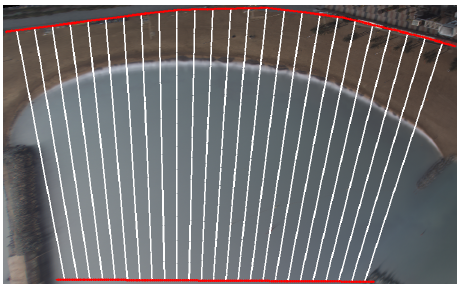
Figure 2. Somorrostro beach in Barcelona (beach BCN3): polylines (in red) defining the boundary and a subset of the transects (in